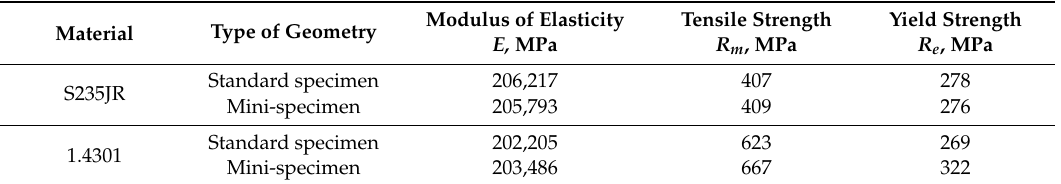
Figure 2. Stress–strain curve for steels: ( a ) S235JR; ( b ) 1.4301. Table 3. Mechanical properties.